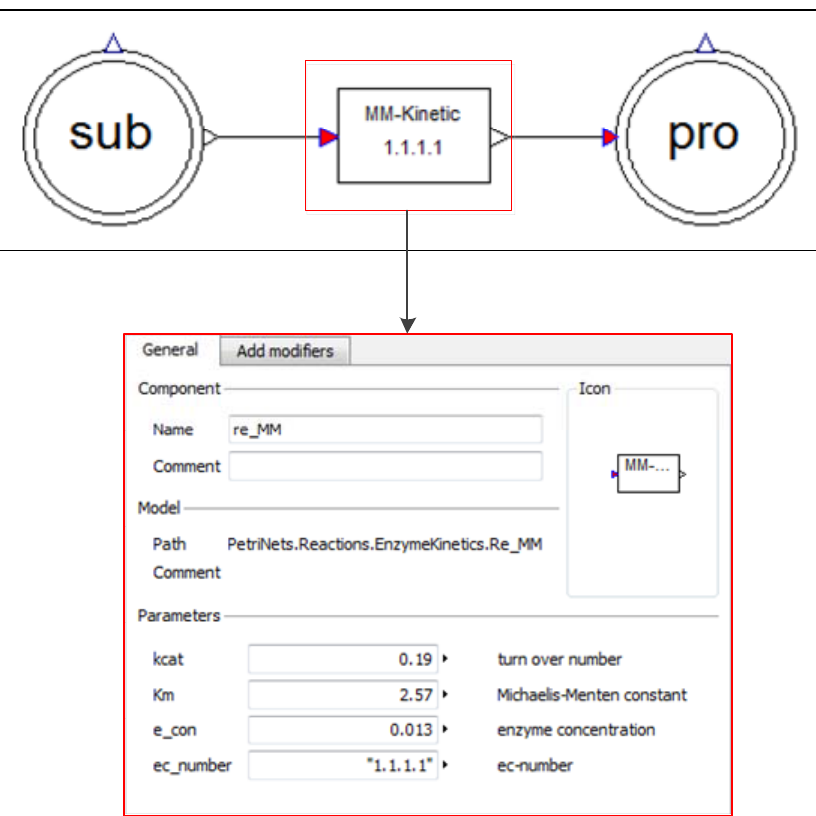
Figure 14: Property dialog of the Michaelis-Menten Kinetics